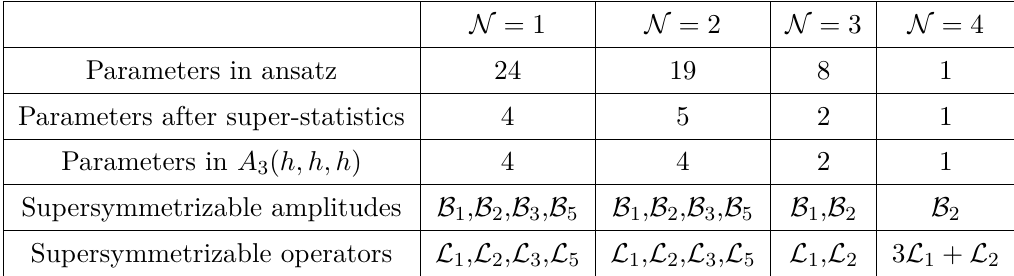
Table 2. Summary of supersymmetry constraints on cubic massive spin-2 interactions. The explicit form of the amplitudes B i are given in (3.5), and the correspondence with local operators L i in (3.6). In general, arbitrary linear combinations of the listed amplitudes (operators) are consistent with supersymmetry, except for N = 4 where only a specific linear combination of operators L 1 and L 2 is